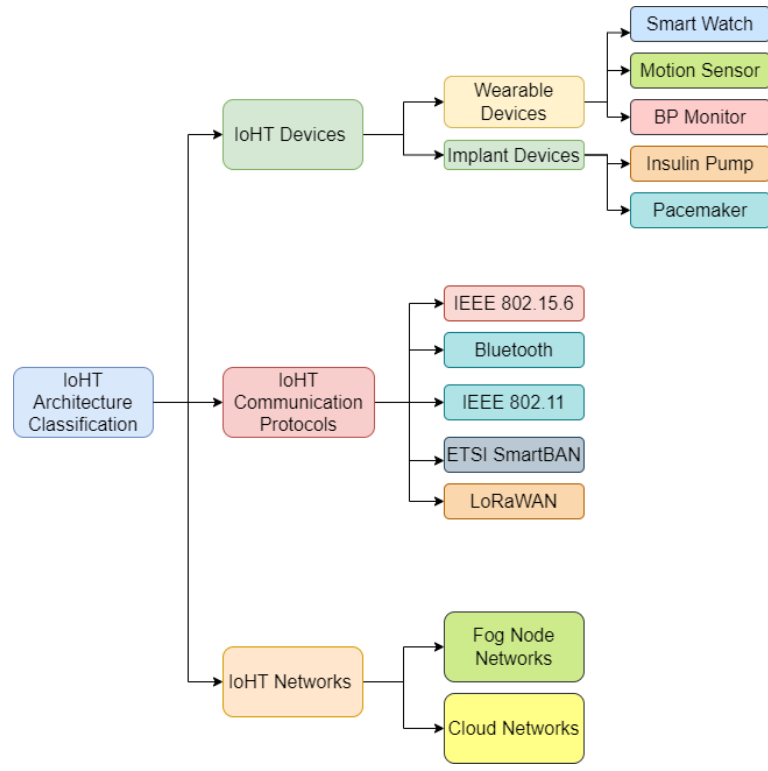
Figure 2. IoHT Architecture Classification.